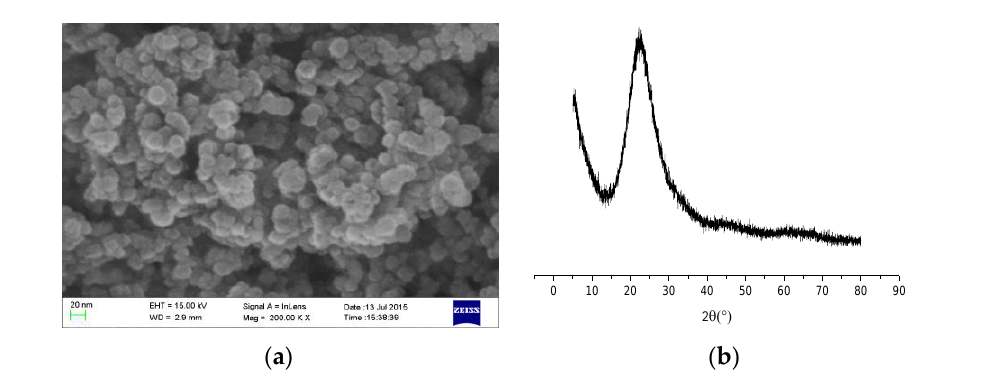
Figure 1. ( a ) Scanning electron microscopic (SEM) patterns of nano-silica; ( b ) X-ray diffraction (XRD) patterns of nano-silica.